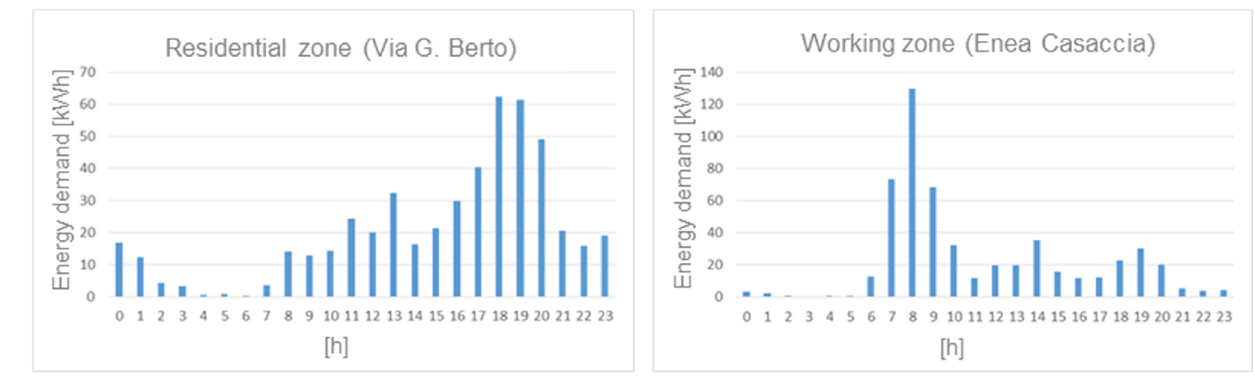
Figure 10. Examples of energy demand computation for two different land use zones in the city of Rome.